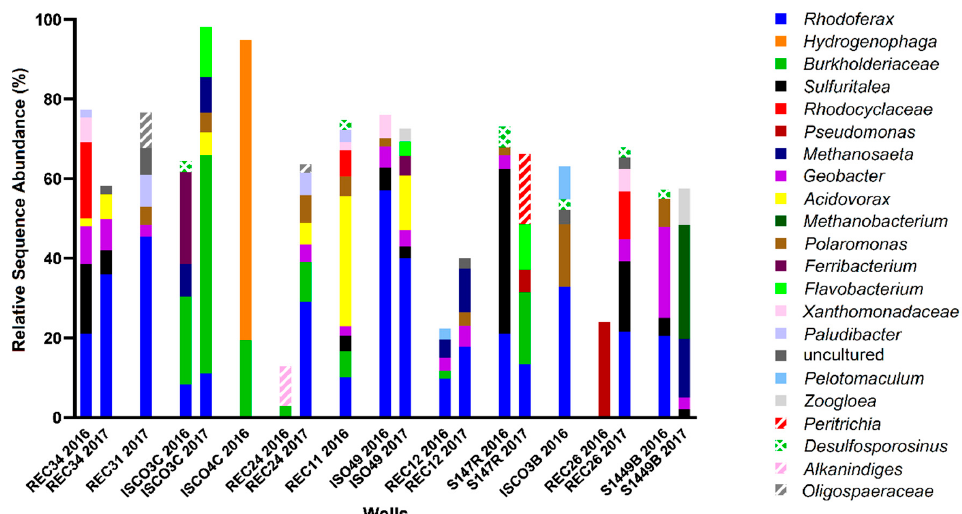
Figure 4. Microbial community profiles found with Site B groundwater wells in 2016 and 2017, with wells arranged in order of decreasing total hydrocarbon concentration, from left to right. Analysis was performed using MetaAmp 2.0 and the SILVA 132 database, with the 2% most abundant taxa shown to the lowest taxonomic level identified.